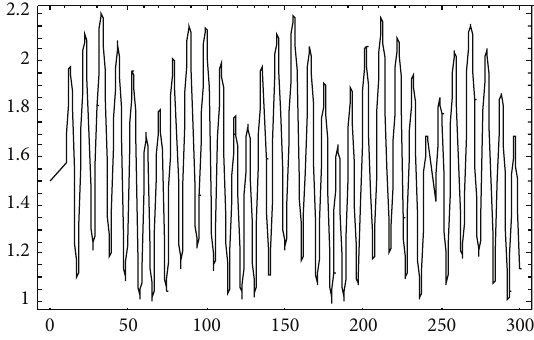
Figure 5: Time series analysis of e 1 ( f ).